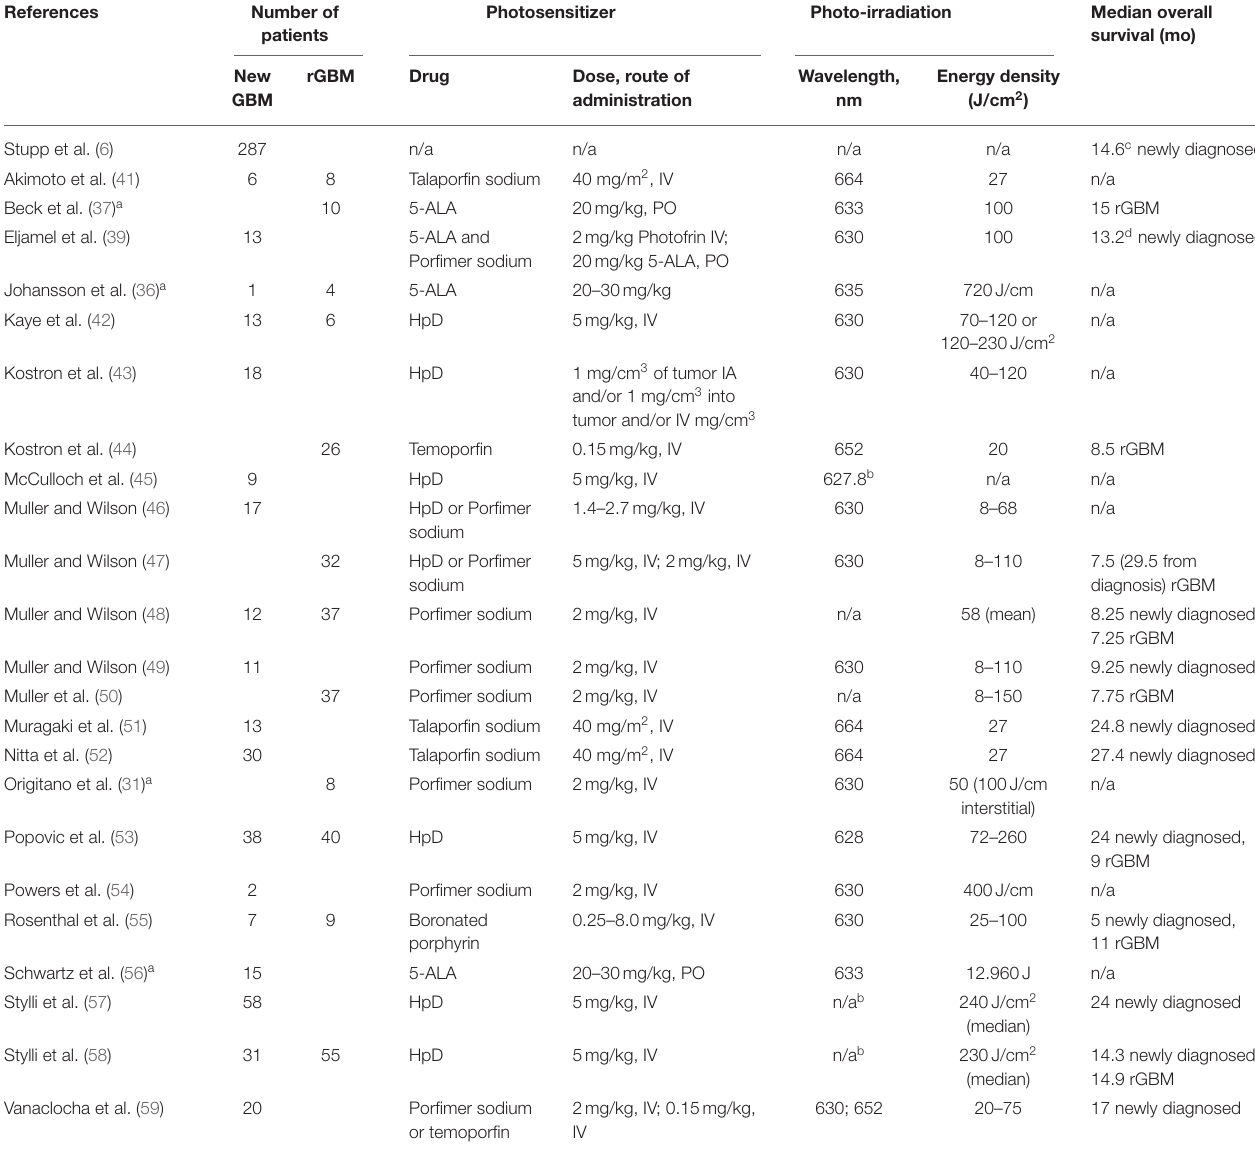
TABLE 2 | Summary of clinical trials using PDT for the treatment of